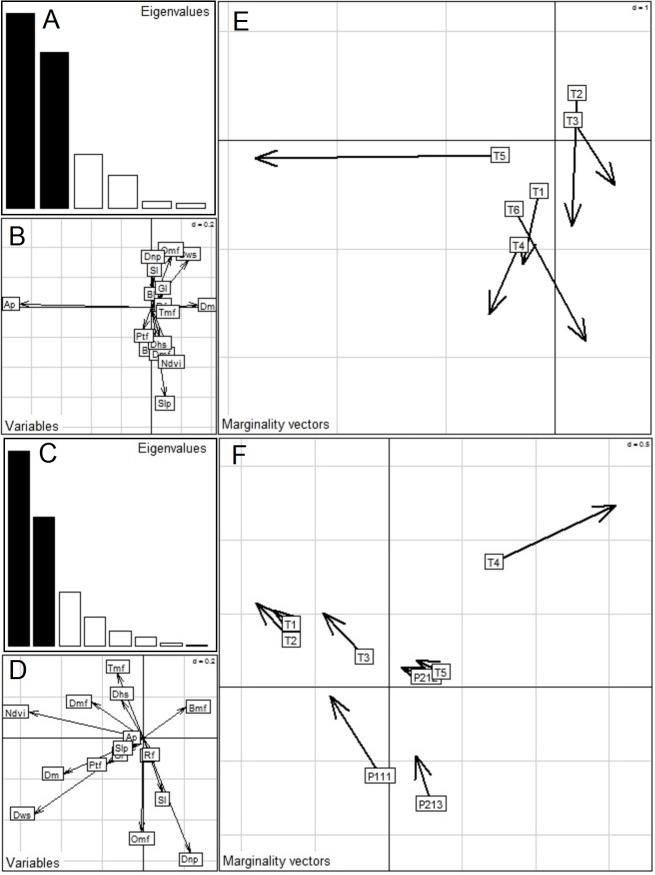
Results of K-select analysis carried out on 16 habitat variables to highlight habitat selection during the exploratory period and the settled period by 6 reintroduced tigers and 3 offspring.(B) and (D) are habitat variable loadings on first two factorial axes of the exploratory period and the settled period, respectively; (E) and (F) show the projection of marginality vectors of all animals on the first factorial plane during the exploratory and the settled periods, respectively. Both bar charts (A and C) of the eigenvalues show the mean marginality explained by each factorial axis. (Refer to Table 1 for detail descriptions of habitat variable abbreviations).